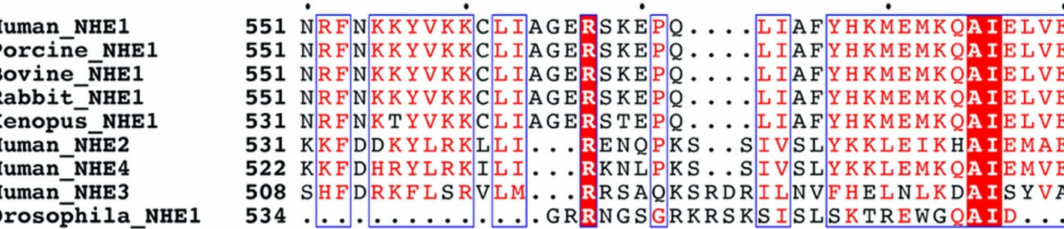
Figure 8. Multiple sequence alignment of amino acids 551–590 of the human NHE1 (P19634) with porcine NHE1 (NP001007104), bovine NHE1 (Q28036), rabbit NHE1 (P23791), Xenopus NHE1 (NP_001081553.1), human–NHE2 (NP_003039.2), human–NHE3 (NP_004165.2), human–NHE4 (NP_001011552.2), and Drosophila –NHE1 (NP_608491.3) proteins. Amino acids in the red box show conserved residues. Red colored amino acids are similar in type. Red shading indicates conserved amino acids throughout all species examined. The alignment was made